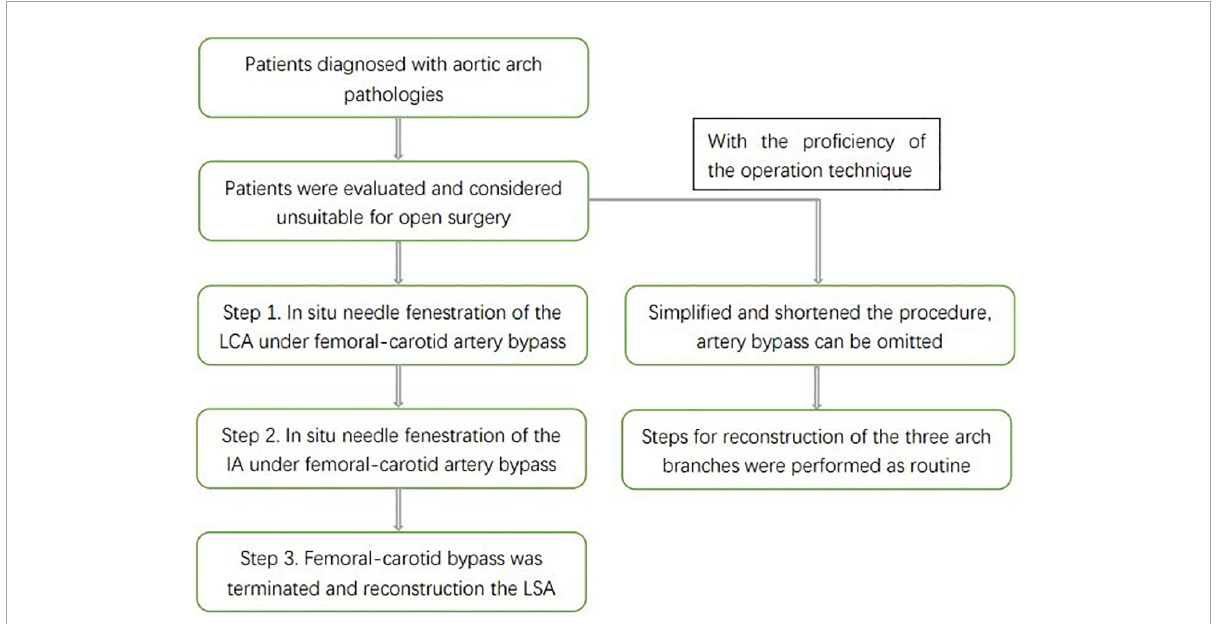
FIGURE1 A schematic drawing that illustrates the intervention steps of endovascular aortic arch